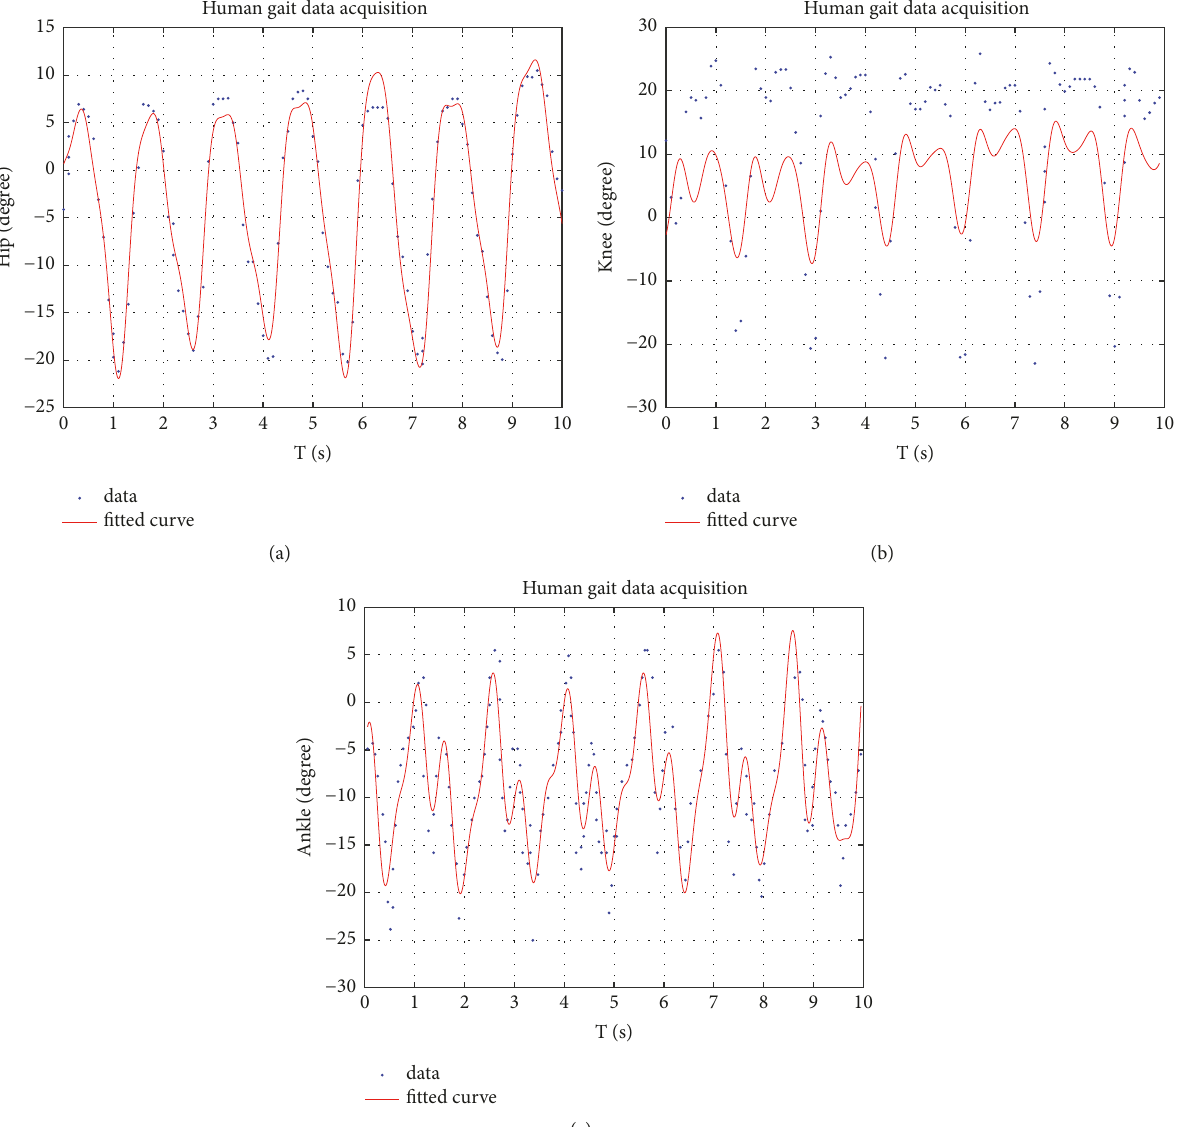
Figure 11: The movement law on each human joint for the swing